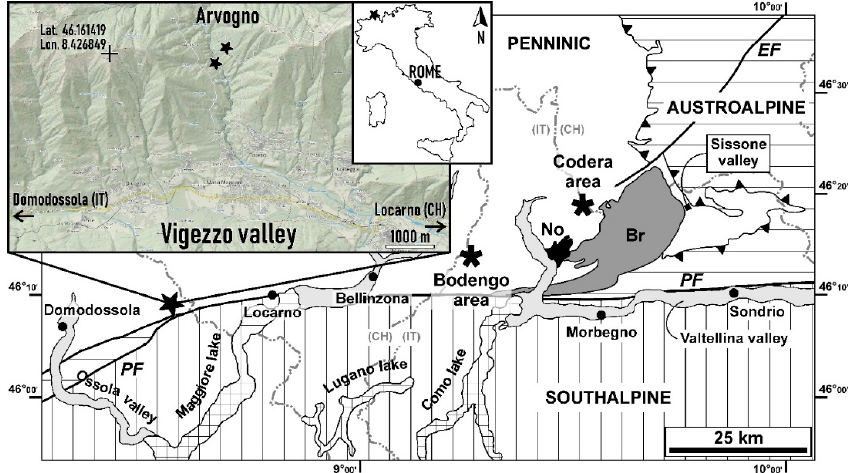
Figure 1. Simplified structural map of the Central Alps with the field of the Alpine pegmatites showing the locations of the Vigezzo, Codera, and the Bodengo areas. The thick black lines represent the Periadriatic Fault ( PF ), the Giudicarie Fault ( GF ), and the Engadine Fault ( EF ). The light-grey areas represent quaternary deposits along major valleys. The tertiary batholith of Bergell (Br) is in dark-grey, and the smaller, younger Novate stockwork intrusion (No) is in black. A detailed sketched map of the geographical location of the Vigezzo valley between Domodossola in Italy (IT) towards the west and Locarno in Switzerland (CH) is shown in the upper left of the figure. The location of the Arvogno pegmatites are shown with stars.